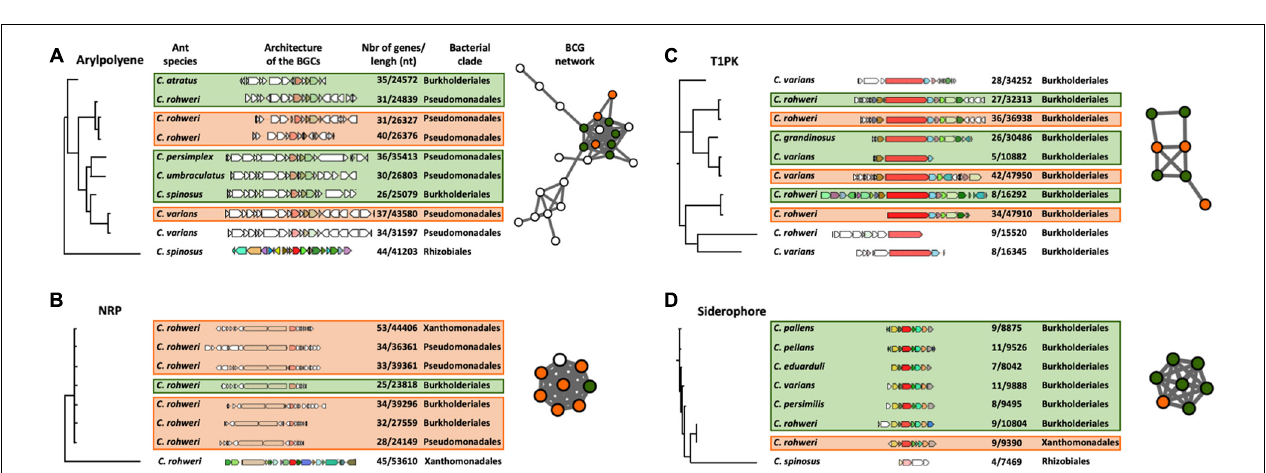
FIGURE 3 | CORASON phylogenetic reconstruction of aryl polyene (A) , NRP (B) , T1PK (C) , and siderophore (D) BGCs. Because of their large size, only a selected clade of the aryl polyene and NRP phylogenies is presented here. The whole phylogenies of these clusters can be found in Supplementary Figures 6 , 7 . These phylogenies show the genomic composition of each BGC, the size and number of genes of each BGC, the bacterial origin of the BGC (on the right of the BGC), and the host ant species (on the left of the BGC). Each colored BGC in the phylogeny is represented as a node in the networks which were generated in the previous genetic network analysis ( Figure 2 ). The nodes in the network are colored orange for BGCs originating from a bacterial genome or green for BGCs originating from a metagenome. The white nodes represent BGCs present in the network analysis but were not found in the phylogenetic clade presented here.